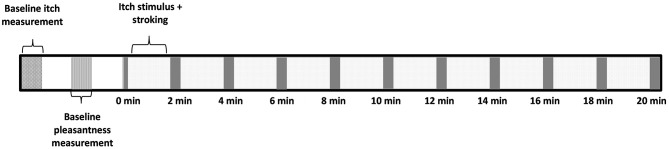
Outline in time of a single condition.